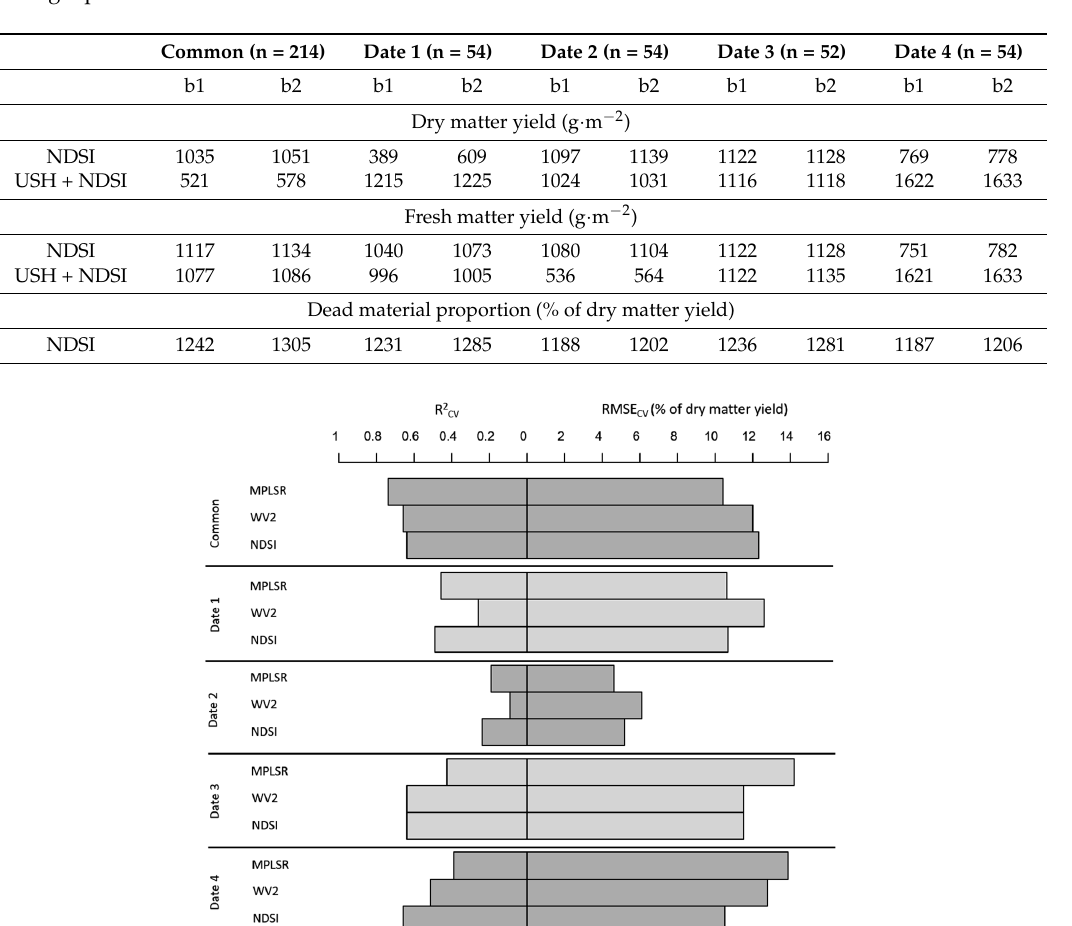
Figure 3. Cross-validation (CV) results for a range of sensor models used for prediction of dead material proportion (DMP), including exclusive use of all hyperspectral wavebands using modified partial least squares regression (MPLSR), normalized difference spectral index (NDSI), and multispectral representation of WorldView-2 wavebands (WV2) as explanatory variables.